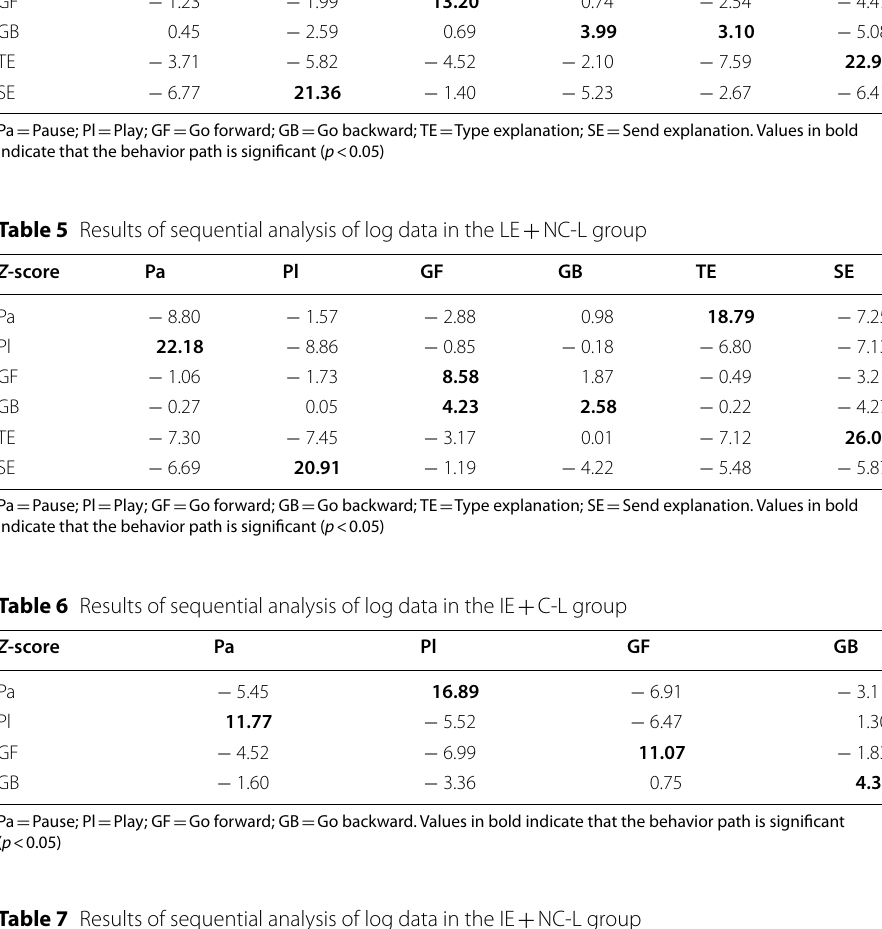
Table 7 Results of sequential analysis of log data in the IE